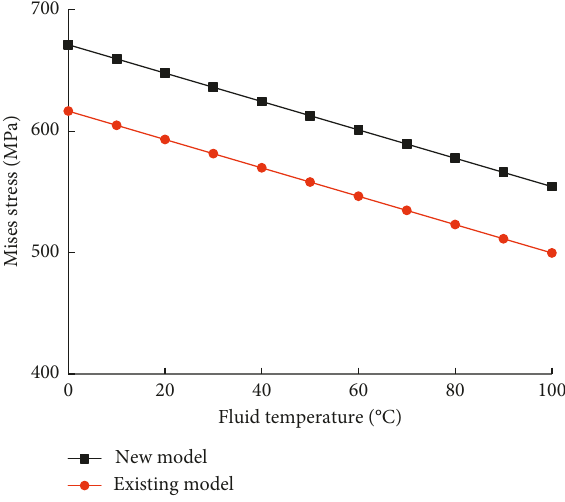
Figure 20: Casing Mises stress for different